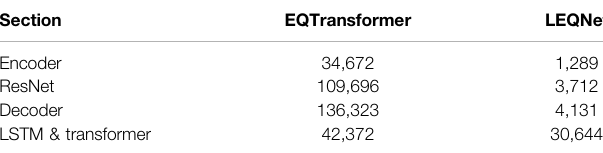
TABLE 1 | Number of parameters in the EQTransformer and LEQNet.